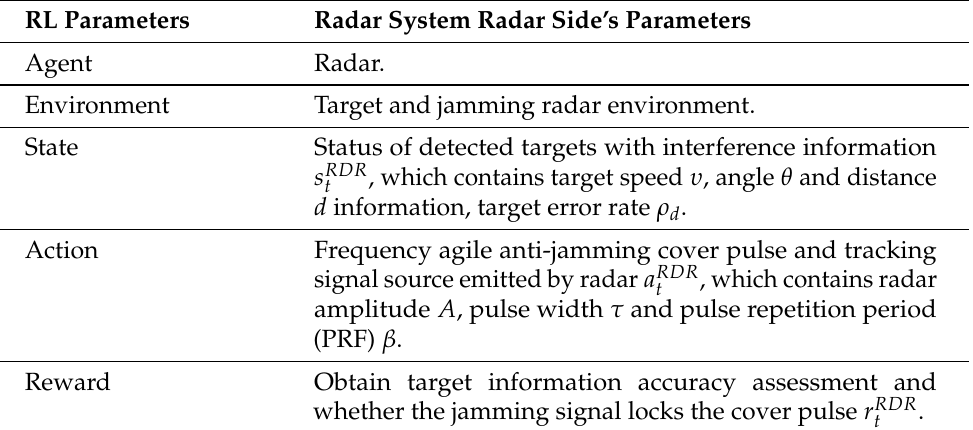
Table 2. Definition of radar parameters of radar-jammer system environment